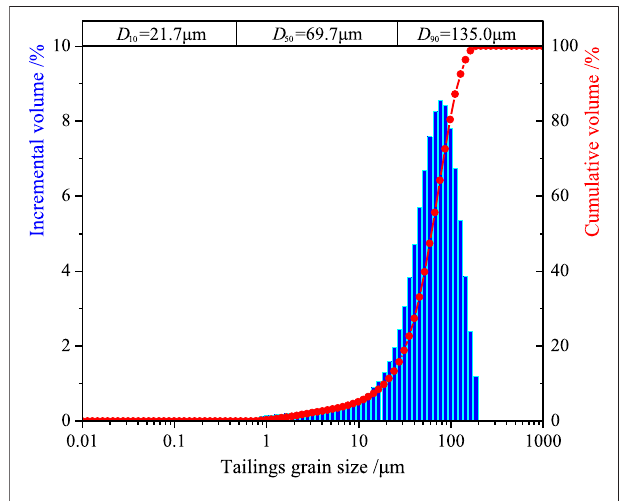
FIGURE 1 | Particle size distribution of tailings.